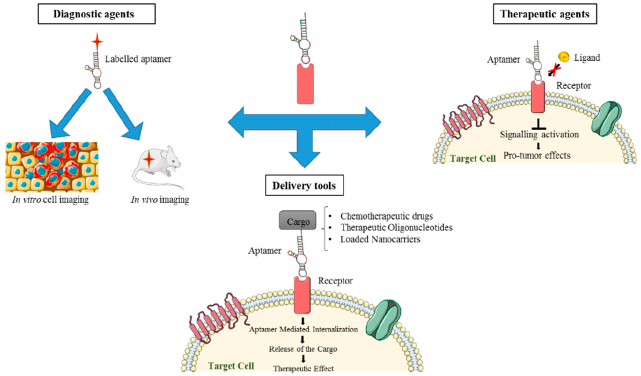
Figure 1. Aptamer biomedical applicability. Aptamers show great potential as diagnostic and therapeutic tools and as delivery carriers of secondary therapeutics. therapeutic tools and as delivery carriers of secondary